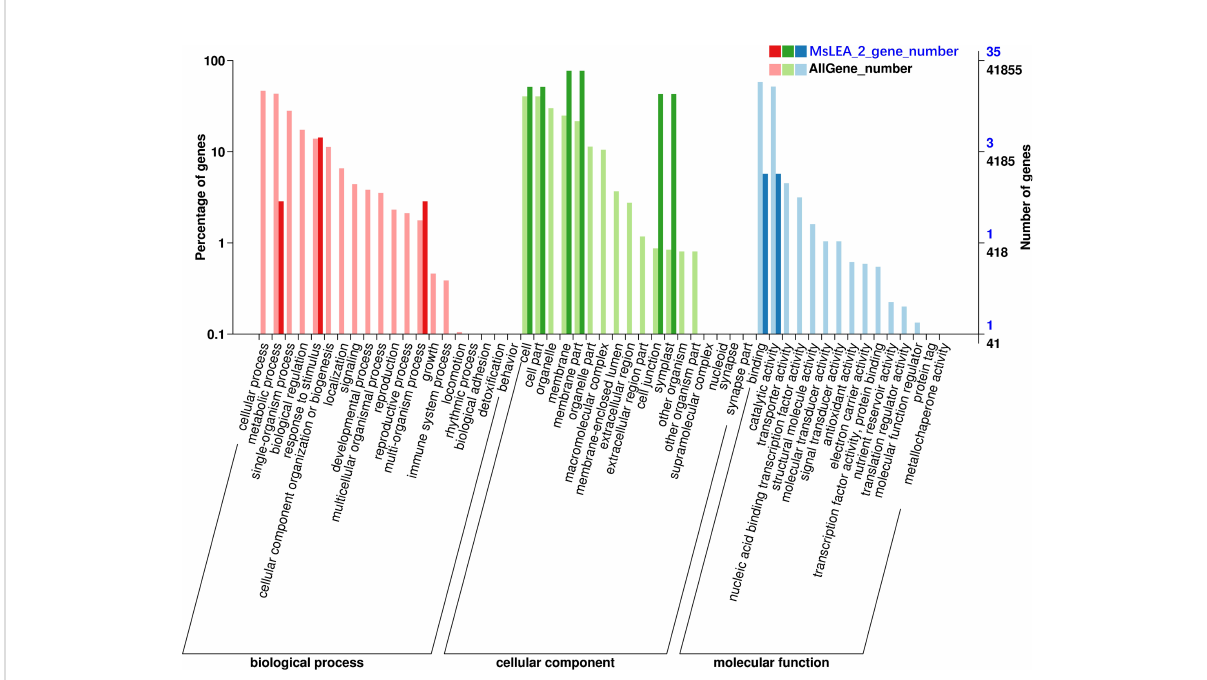
FIGURE 7 Gene Ontology (GO) classi fi cation of MsLEA_2 family genes. The y-axis is the percentage of genes mapped by the term and represents the abundance of the GO term. The x-axis is the de fi nition of the GO terms. The GO function annotation of all genes in alfalfa was used as a control. The MsLEA_2 gene family contain 10 GO categories, which belonged to molecular function (MF), biological process (BP) and cellular component